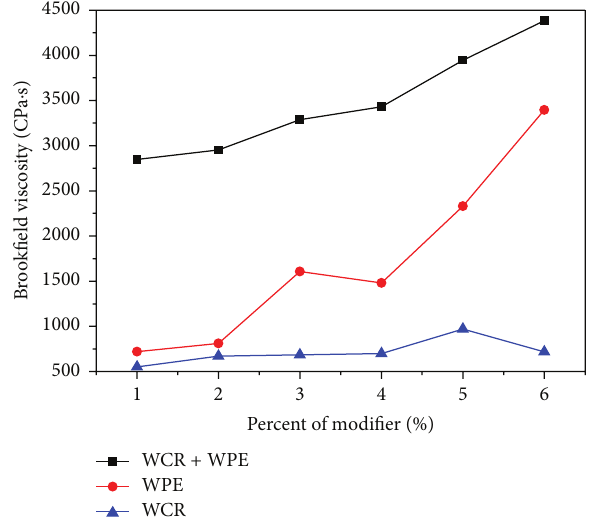
Figure 4: The viscosity of modified asphalt at 135 ∘ C.